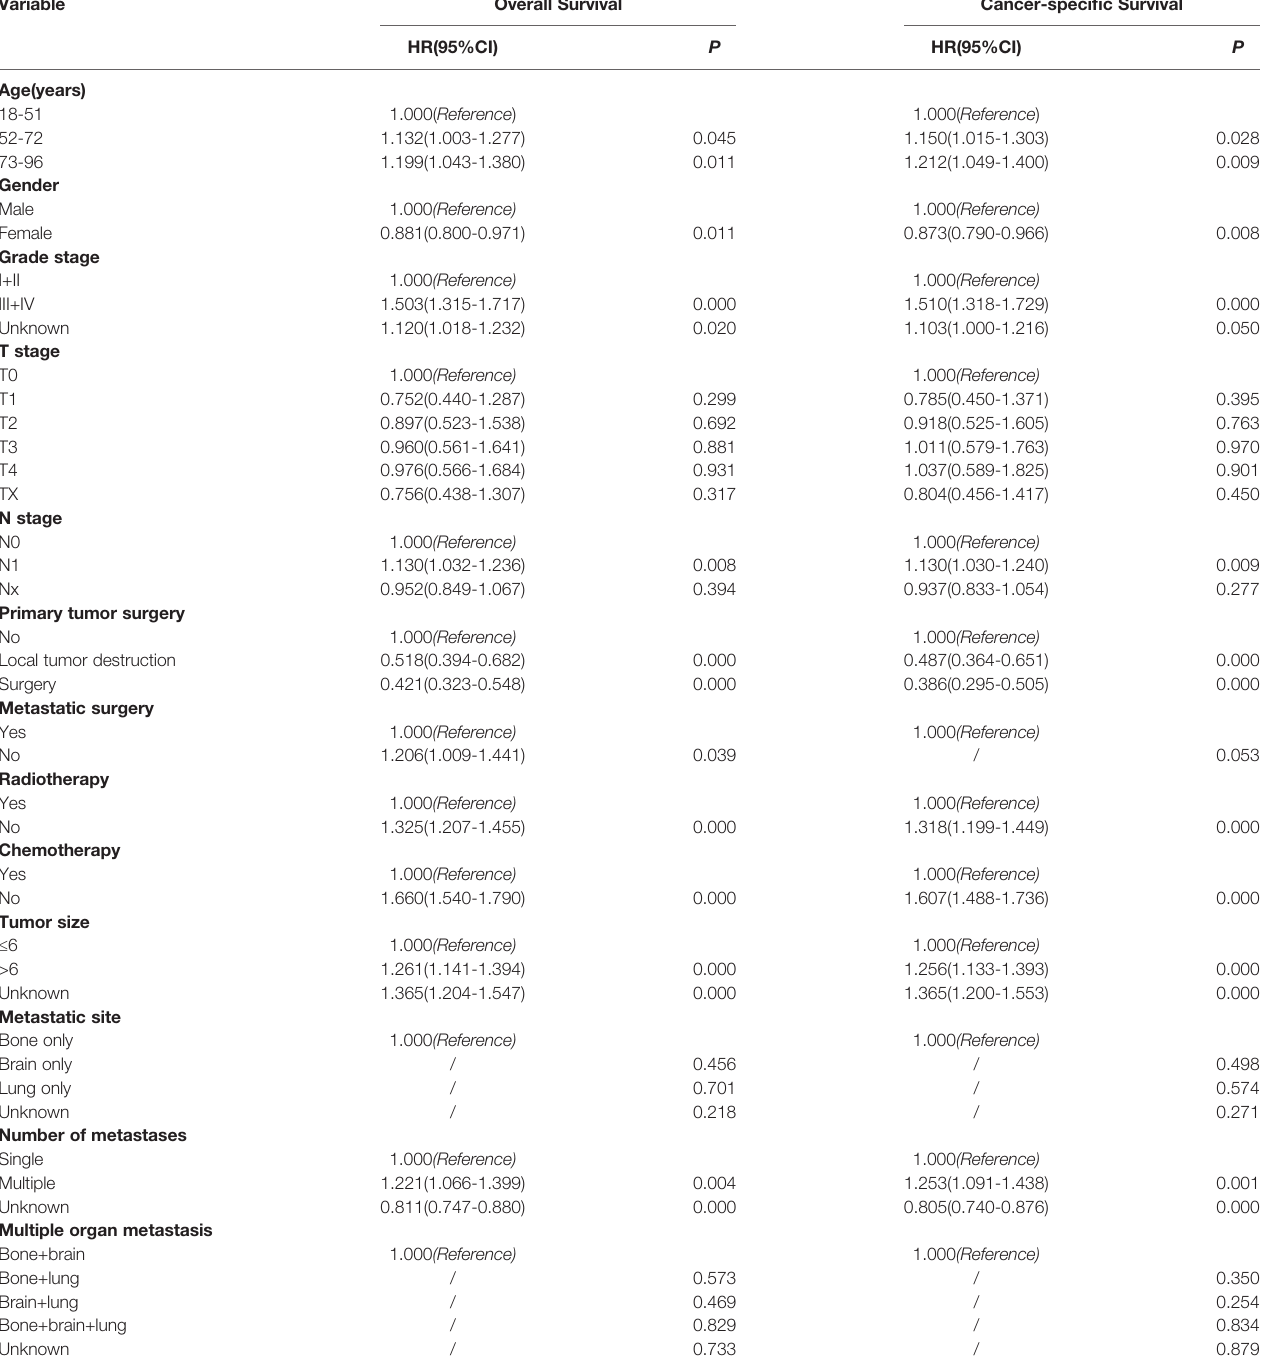
TABLE 2 | Multivariate analysis of prognosis for distant metastasis of